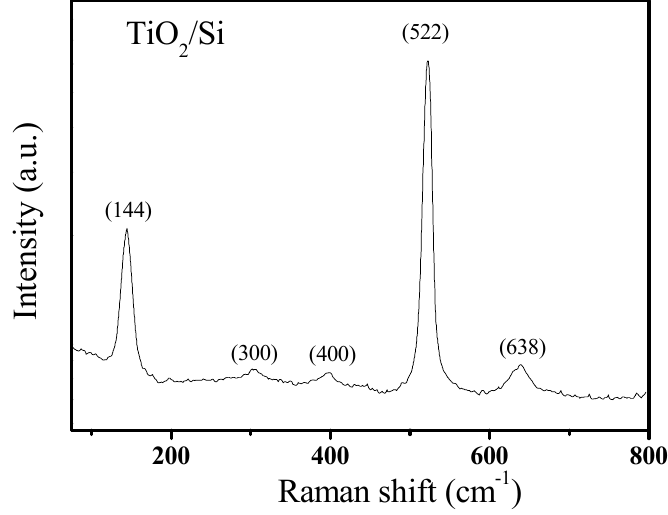
Figure 4. The micro-Raman spectrum for TiO 2 /Si at room temperature.